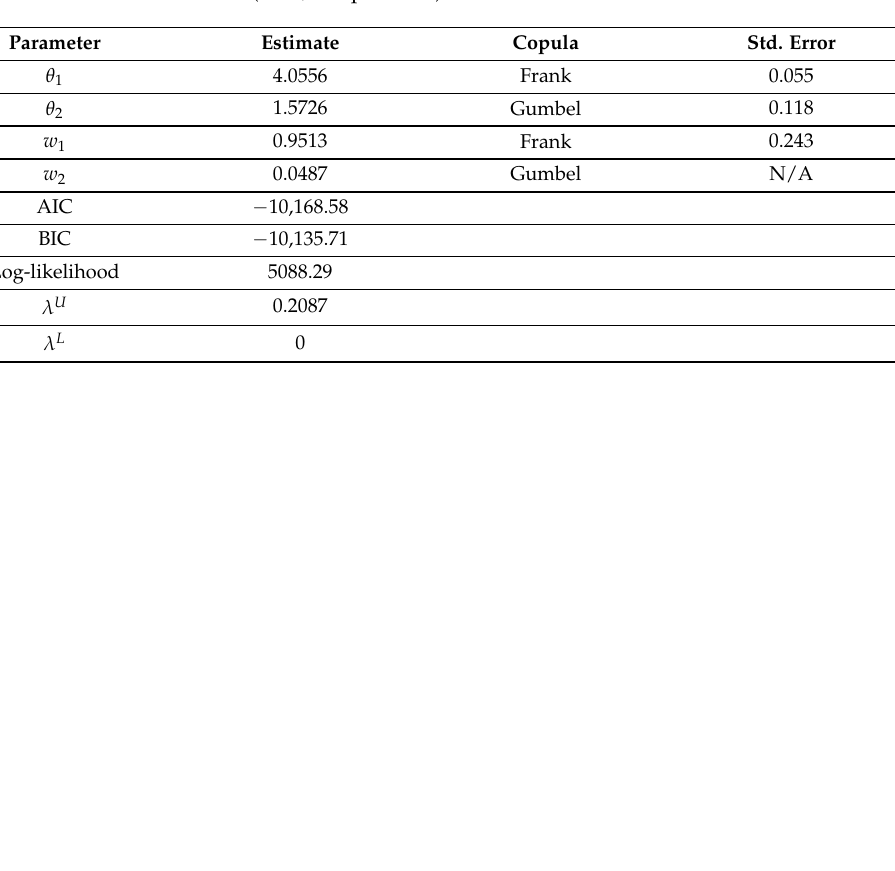
Table 7. Frank-Gumbel mixture (GHI,